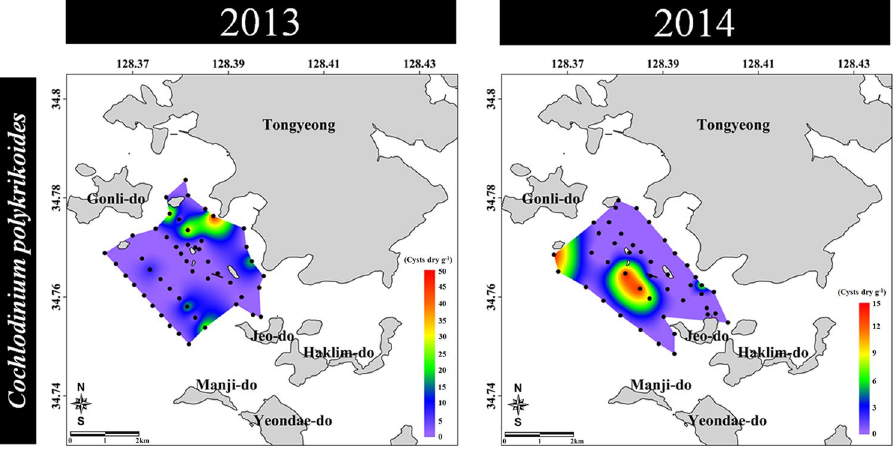
Figure 5. Cyst distribution of Cochlodinium polykrikoides (revealed by morphological analysis) in surface sediments of Tongyeong coast (South Sea) of South Korea during December 2013 (50 sampling sites) and September 2014 (44 sampling site). All maps were generated with Surfer v12.2.705 (http://www.goldensoftware.